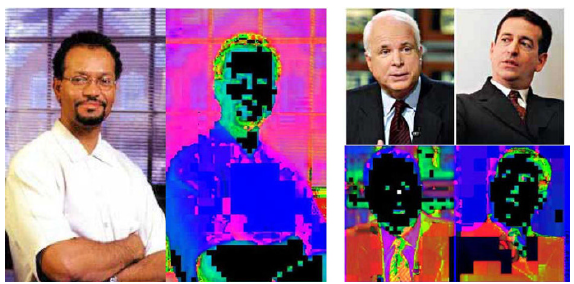
Figure 2: Skin tone segmentation using HS histogram model in Figure 1. Black pixels have been identified.